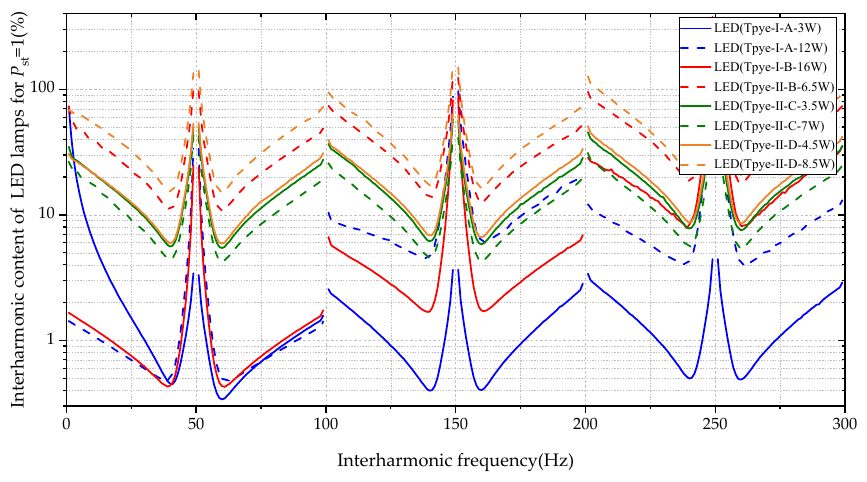
Figure 8. Interharmonic-flicker limit curve of test LED lamps.